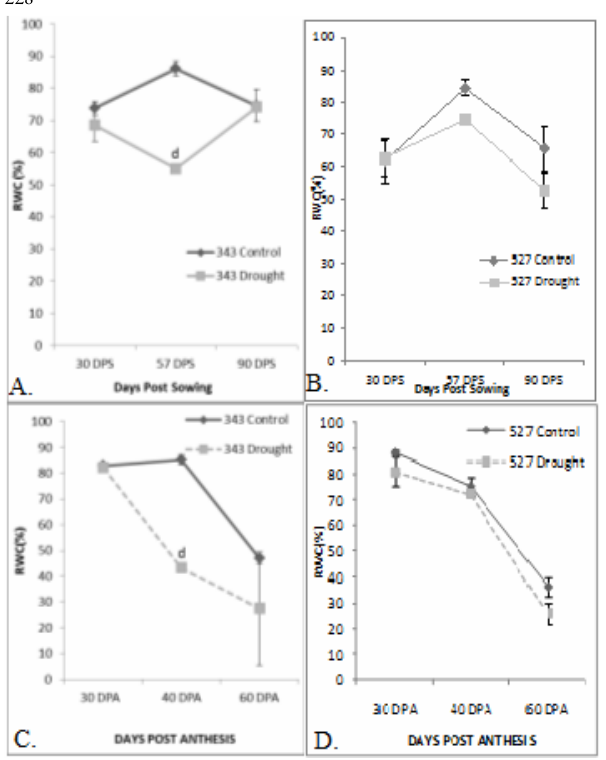
Fig. 2 : Relative Water Content (RWC) in shoots (A, B) and seeds (C, D) of drought sensitive cv. ‘PBW 343 ʼ (A, C) and drought tolerant cv. ‘PBW 527 ’ (B, D) cultivars of T. aestivum harvested at three different vegetative and reproductive stages : 30 DPS , 57 DPS, 90 DPS and 30 DPA, 40 DPA and 60 DPA respectively under control and drought conditions. DPS: Days Post Sowing. DPA: Days Post Anthesis. Data shown are Mean ±SD of three replicates; d indicates significant difference vs. control at P≤0.05